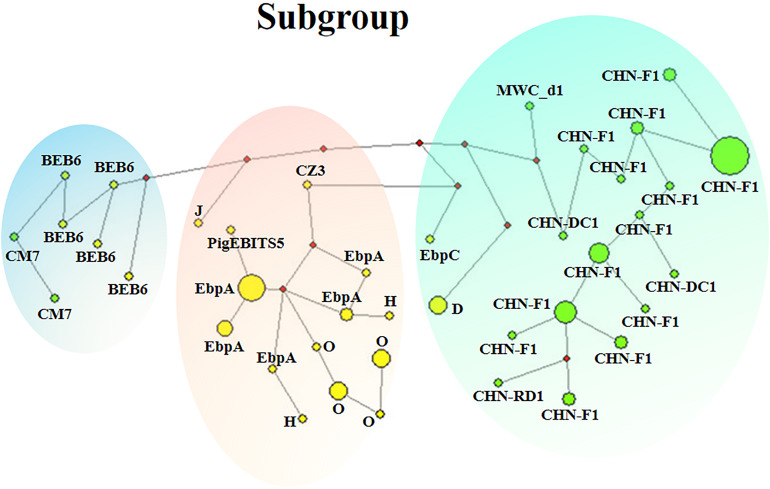
Median-joining network analysis for inferring intraspecific phylogenies of 90 E. bieneusi isolates belonging to 14 ITS genotypes from eight mammal species. The yellow and green colors in circles represent zoonotic ITS genotypes and host-adapted ITS genotypes, respectively. The diameter of each circle is proportional to the frequency of each multilocus genotype (MLG) on the basis of polymorphic/segregating sites of concatenated sequences of the five genetic loci including ITS. Length of lines connecting MLGs is proportional to the number of single nucleotide polymorphisms. ITS genotypes are labeled besides the circles. Three clusters marked in green, pink and blue are corresponded to subgroups 1–3, respectively.